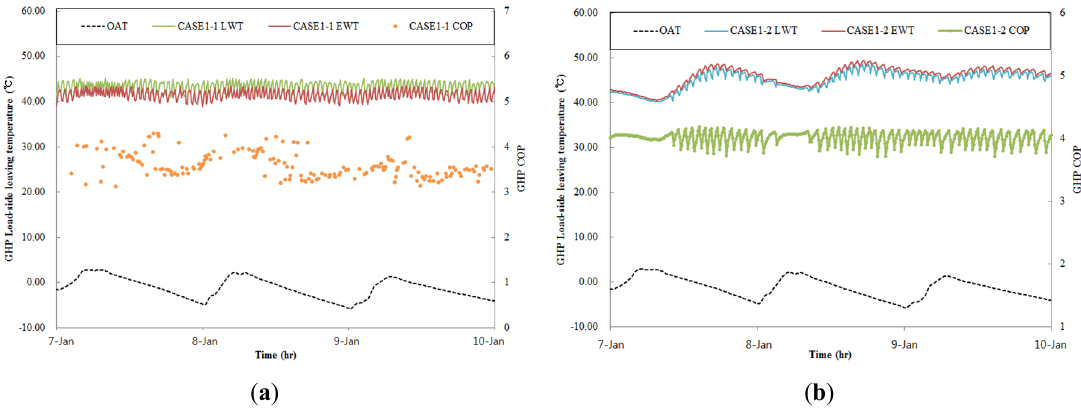
Figure 16. COP and winter hot water inlet-outlet temperatures for the Multi-GHP system: ( a ) existing operation condition of Multi-GHP system (Case 1-1); ( b ) sequencing operation condition of Multi-GHP system (Case